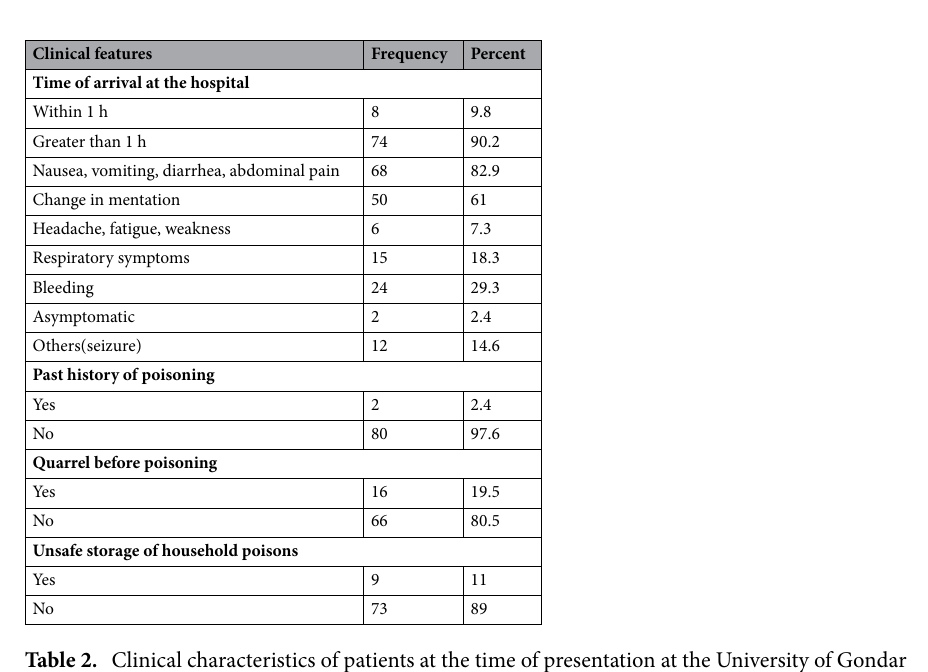
Figure 3. Overall poisoned case distributions by method of poisoning and their short-term outcomes.